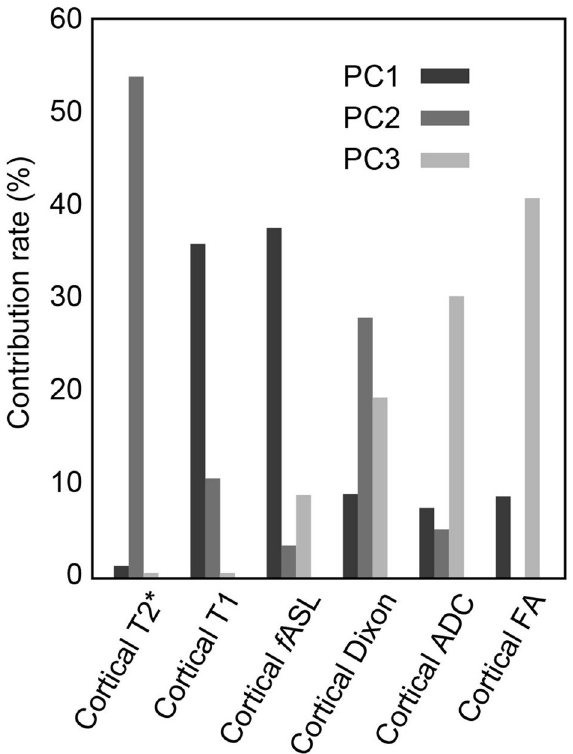
Figure 1. Principal component analysis for each MRI. PC Principal component, fASL perfusion volume estimated by arterial spin labelling, Dixon signal intensity of Dixon water image, ADC apparent diffusion coefficients, FA fractional anisotropy. PC1 reflects renal blood flow and inflammatory changes. PC2 is an indicator of hypoxia. PC3 is an indicator of fibrosis and associated microstructural degeneration; Dixon water imaging contributed weakly to all